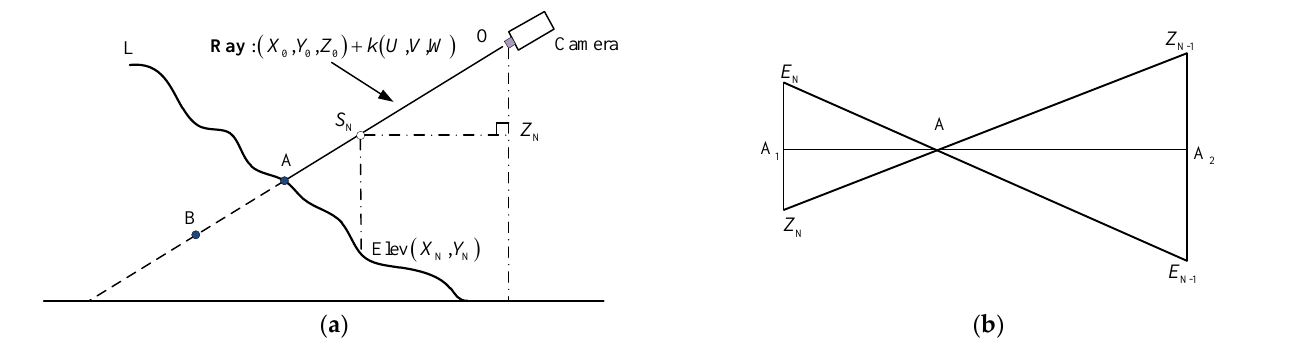
Figure 2. Ray intersection with the DSM. ( a ) Calculation model of the intersection’s location between an imaging ray and the DSM; ( b ) When Elev ( X N , Y N ) > Z N , there is